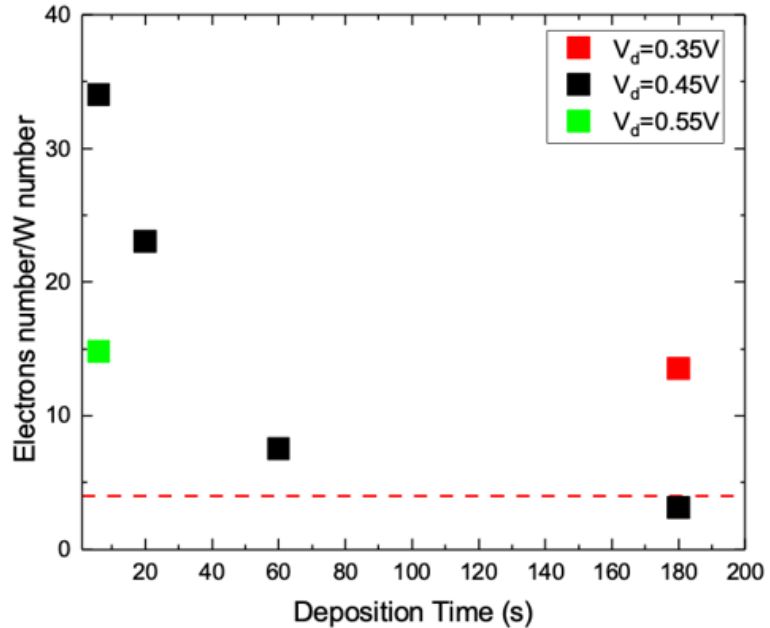
Figure 10. Exchanged electrons during the deposition of a single W atom for the samples deposited at different V d for different t d .